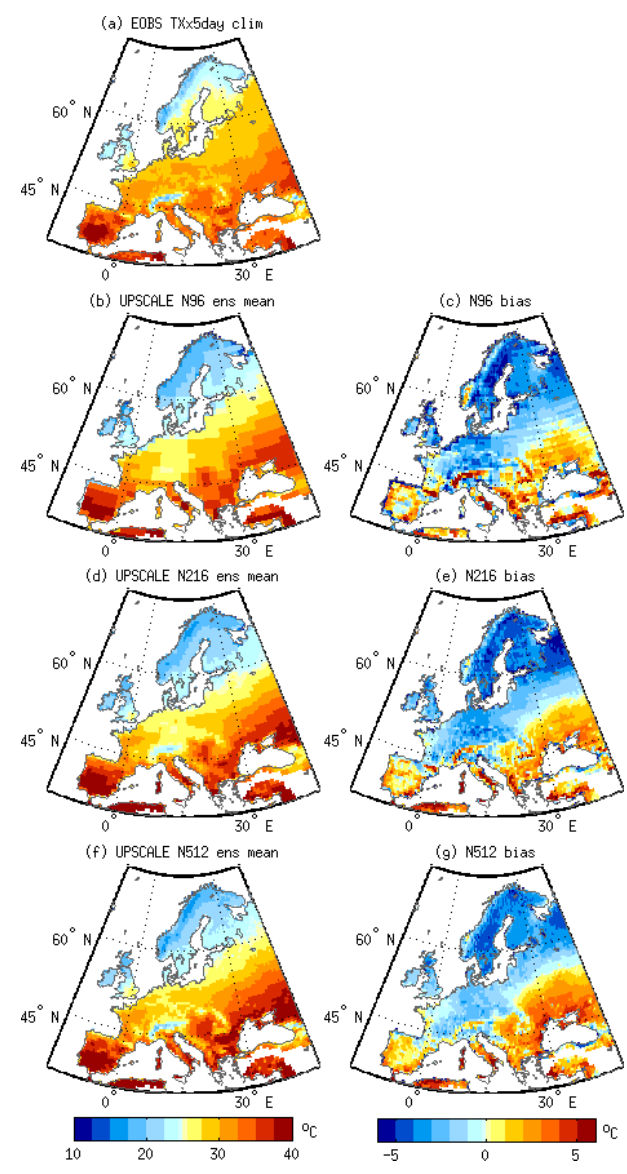
Figure 5. Climatological mean of TXx5day for the ensemble means of three resolutions of HadGEM3-A (UPSCALE) GCM simulations (left) for the period 1985–2011 and their biases with respect to E- OBS (right). (a) E-OBS, (b, c) N96 (130km), (d, e) N216 (60km), and (f, g) N512 (25km). Units: degrees Celsius.